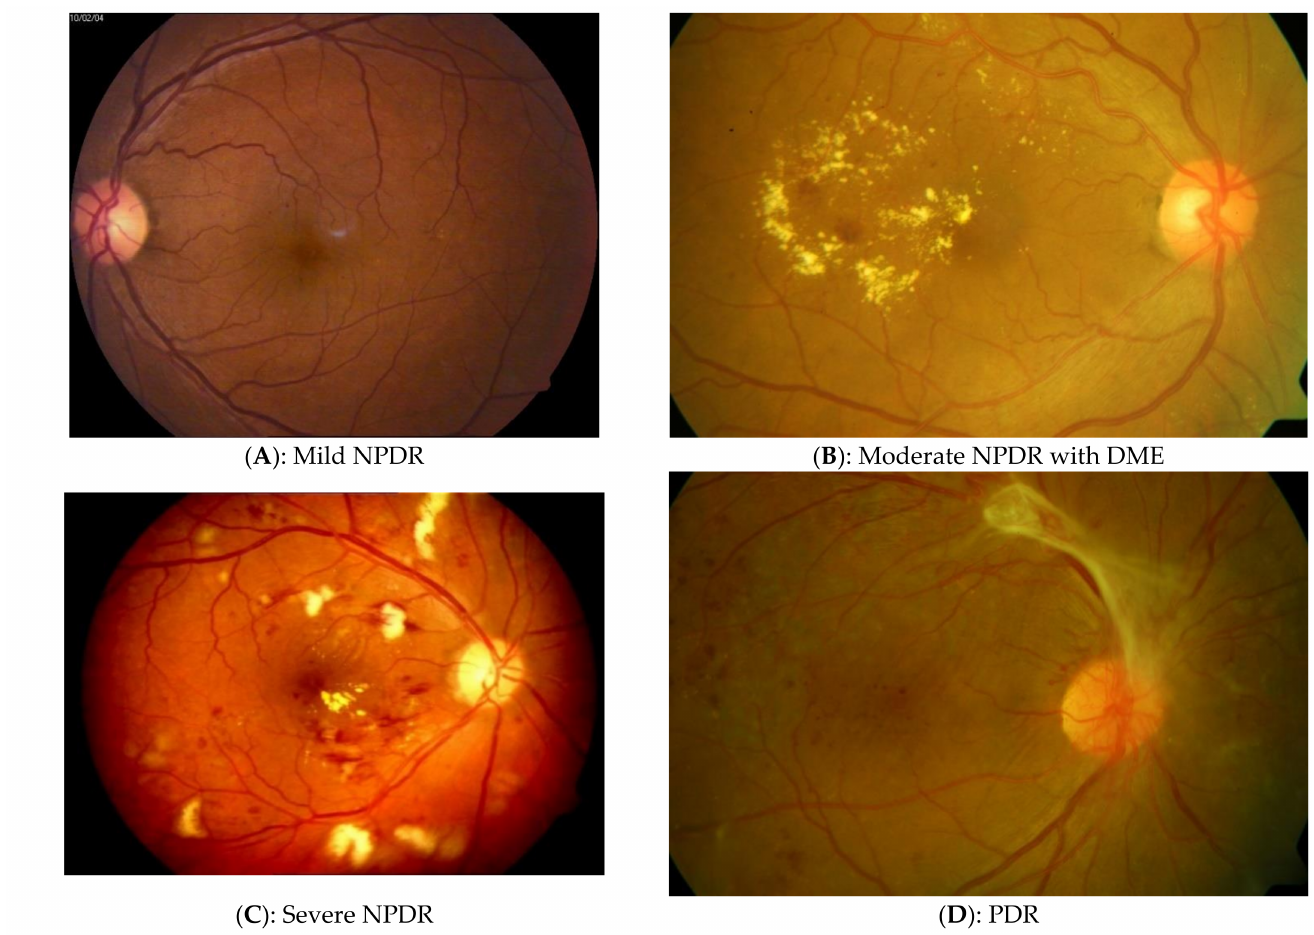
Figure 1. Retinal fundus images of different stages of diabetic retinopathy. ( A ) Stage II: Mild non-proliferative dia- betic retinopathy; ( B ) Stage III: Moderate non-proliferative diabetic retinopathy; ( C ) Stage IV: Severe non-proliferative diabetic retinopathy; ( D ) Stage V: Proliferative diabetic retinopathy (images courtesy of Rajiv Raman et al., Sankara Nethralaya,